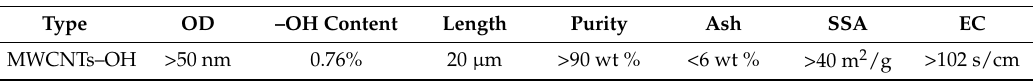
Table 1. Physical properties of MWCNTs–OH.